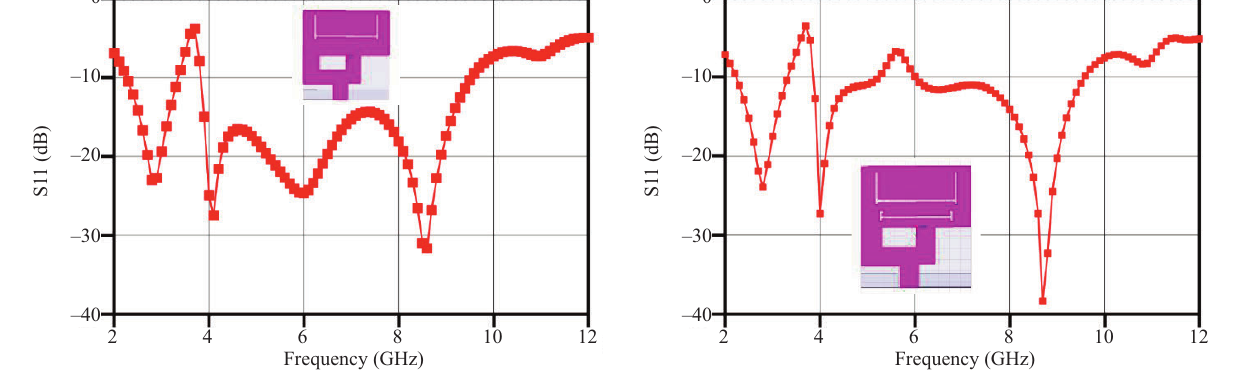
Fig. 5. Simulated S11 response with two H­shaped slots etched on the proposed antennaʼs radiating